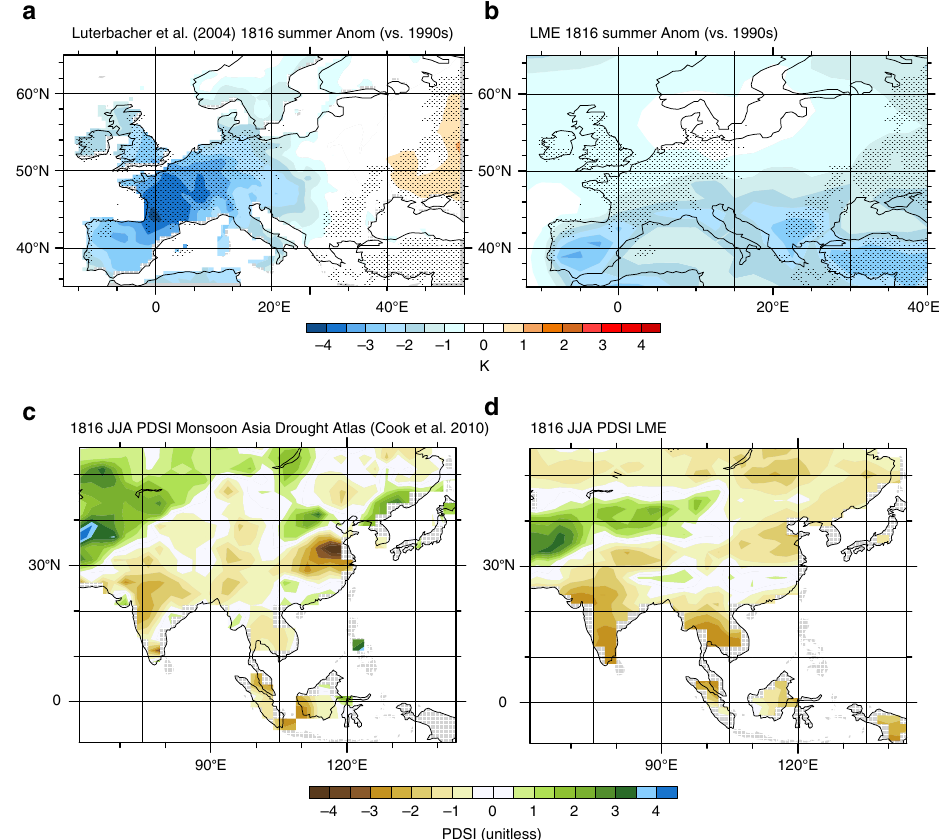
Fig. 1 Proxy reconstructions and LME-simulated responses compared. European 1816 summer temperature anomalies relative to 1990 – 1999 in a proxy reconstructions 26 and b from the LME, and c southeast Asian Palmer Drought Severity Index (PDSI), an indicator of drought 10 , and d their ensemble means over contemporaneous intervals from the LME. Stippling indicates regions where reconstructions lie outside of the ensemble model range for both temperature and